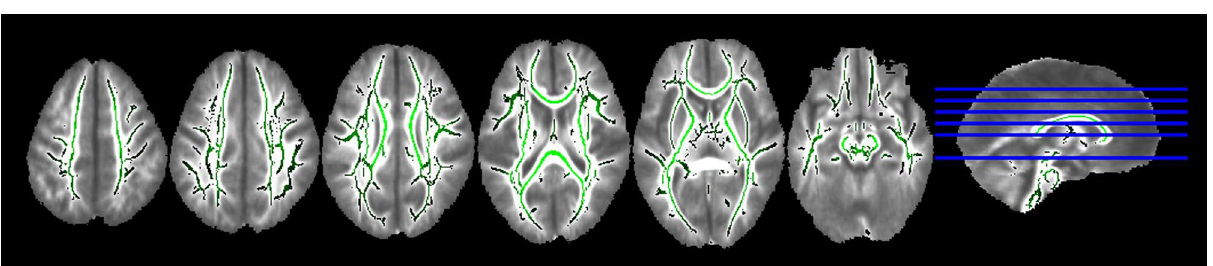
Figure 1. Comparisons of the mean FA maps between two groups. The mean FA skeleton is shown in green, and there were no significant differences between the two groups. FA, fractional